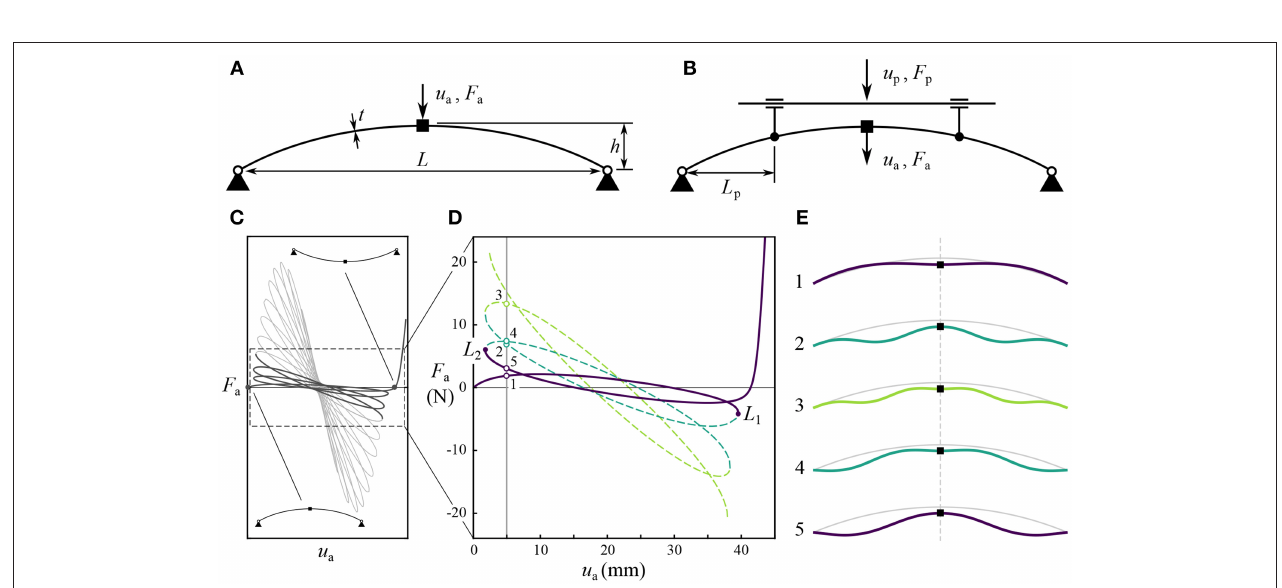
FIGURE 12 | (A) Geometry of the shallow arch. The depth of the arch is not labeled; this dimension is measured into the page. Displacement u a is applied at the mid-span actuation point, generating reaction force F a . (B) Modified geometry including two “probes.” Symmetry is maintained by enforcing vertical displacement u p across both probes, while they are allowed to move horizontally. (C) FEA prediction of the full equilibrium curve from one fundamental state to the other. (D) A subset of the equilibrium curve, starting from each of the fundamental equilibria and showing only the first two limit points on each side; equilibria available at u a numbered 1–5. (E) Deformation shapes associated with equilibria 1–5. This figure has been redrawn from the figures in Neville et al.